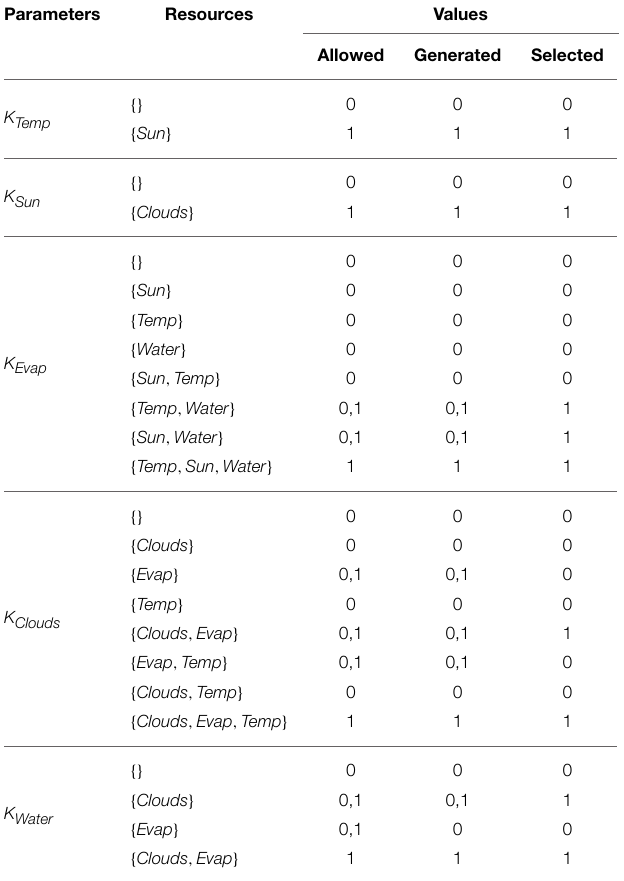
TABLE 3 | Case Study 1: Parameter table. Parameters